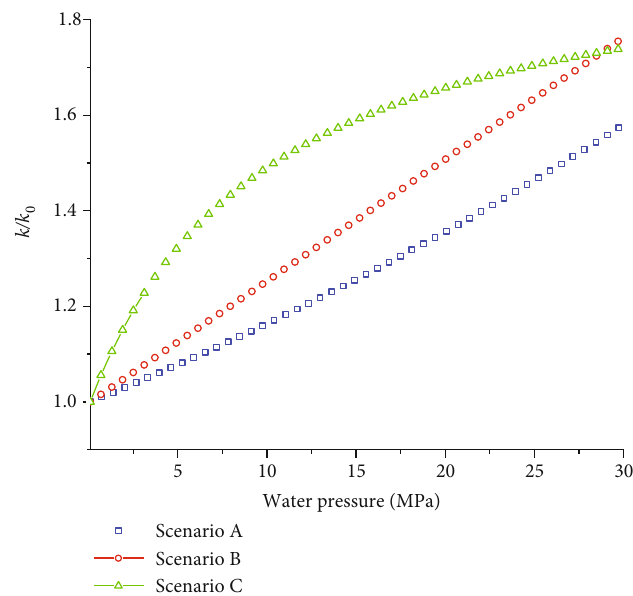
Figure 10: Intrinsic permeability variations with water